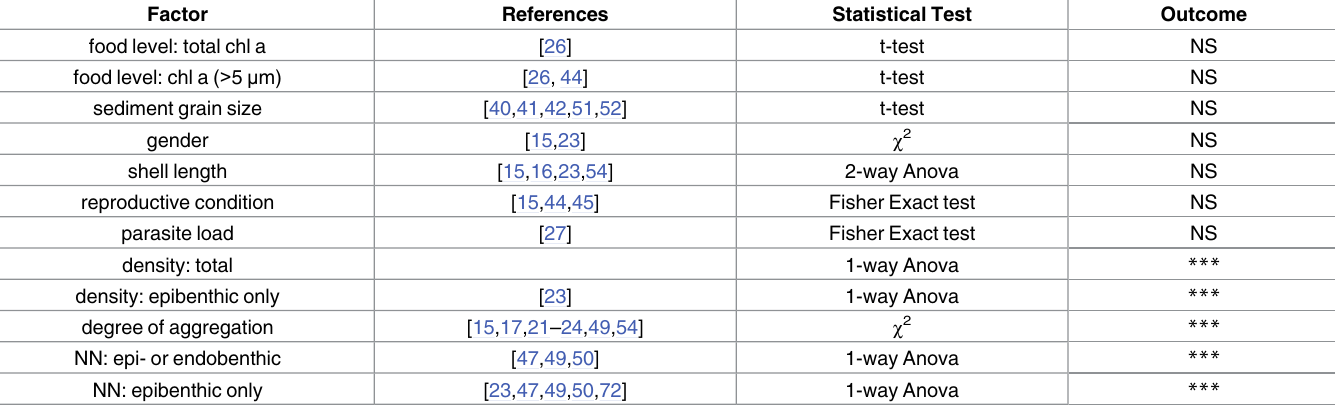
Table 3. Summaryof factors hypothesized to differ between adjacent (~50–60m apart) areas at the East Marion site where hard clam walking was frequently observed (‘walking area’) versus rarely observed (‘non-walking’